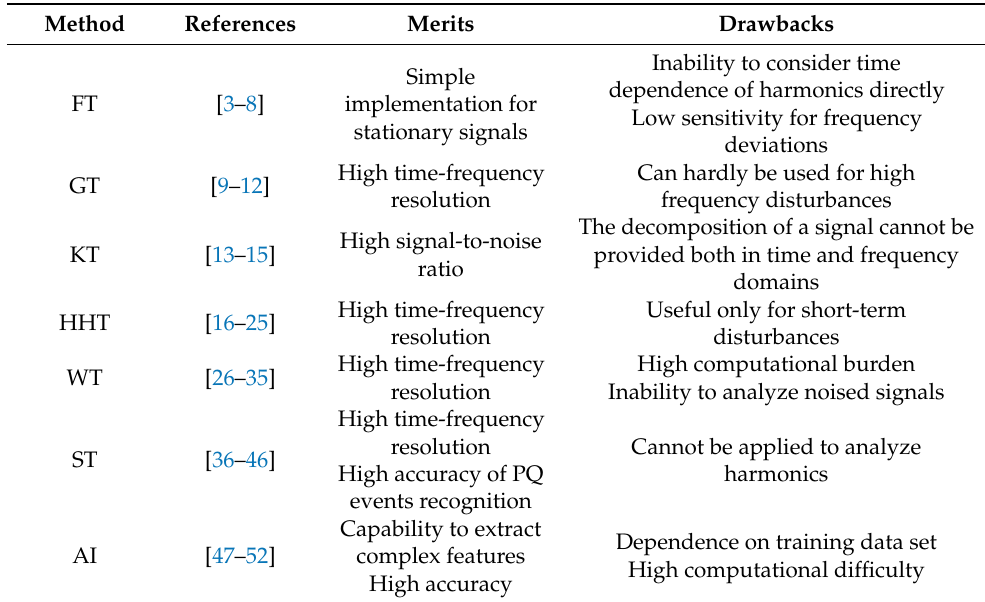
Table 1. Comparison of existing measurement assessment